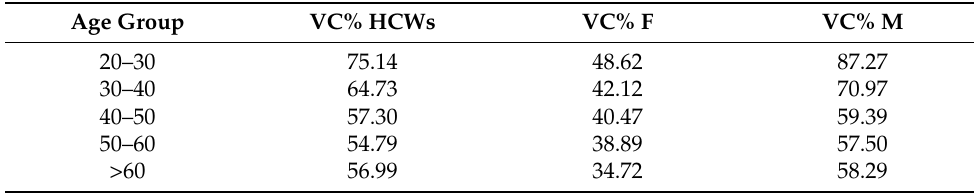
Table 6. Vaccination coverage (VC%) of AOU-SS healthcare workers (HCWs) undergoing